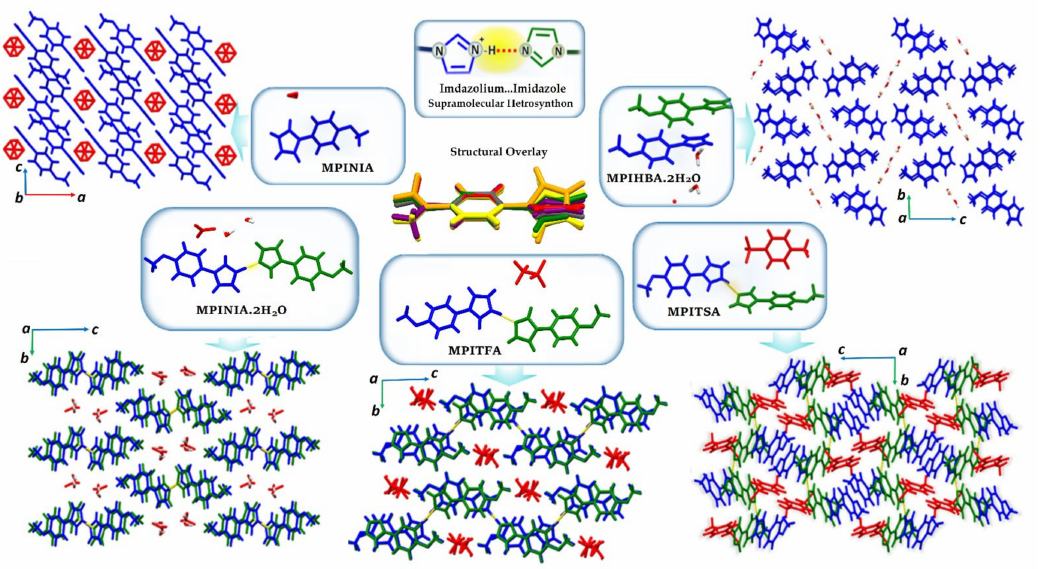
Figure 2. Crystal packing of MPI-based ICCs. Cations are colored blue, neutral coformers green and anions red. Structural overlay of free MPI is presented in the middle of the figure: Free MPI: green, MPIHBA · 2H 2 O: red, MPINIA: orange, MPINIA · 2H 2 O: purple, MPITSA: grey, MPITFA: yellow.